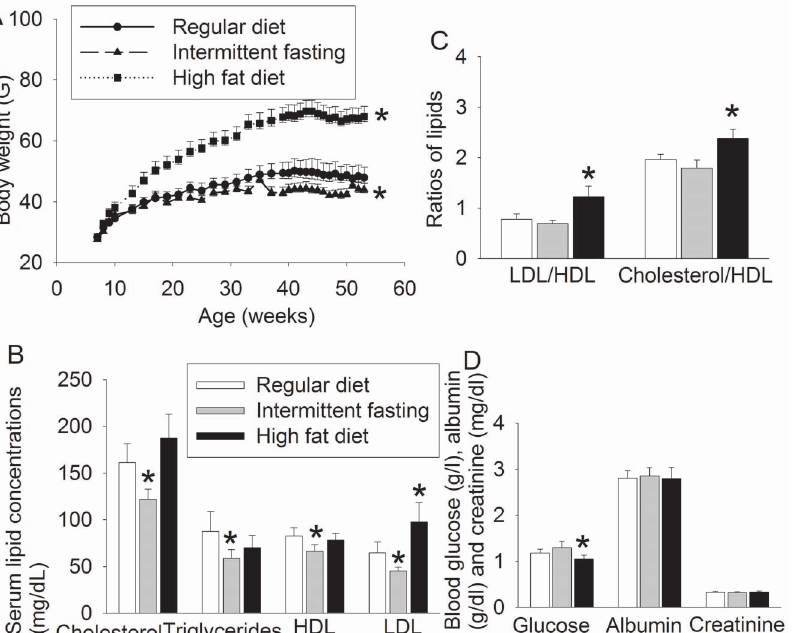
Figure 1. The effects of various feeding protocols on body weights and blood chemicals. Seven-week old male mice had free access to regular chow or high fat diet or were allowed to have free access to regular chow every other day (intermittent fasting) for 11 months. Their growth curves are presented in panel A. Their blood was drawn at the end of the 11-month feeding to measure lipid profiles (panels B and C), glucose, albumin and creatinine (panel D). Results are means 6 S.E.M (n=12 – 15). * P , 0.05 compared with mice on regular chow ad libitum. HDL: high density lipoprotein; LDL: low density lipoprotein.